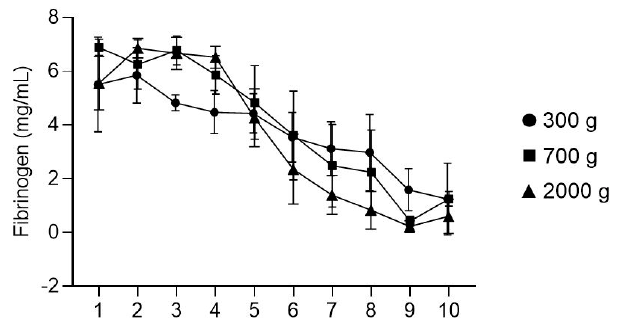
Figure 1. Fibrinogen concentration in 10 fractions of nonclotted centrifuged blood. Liquid PRF was